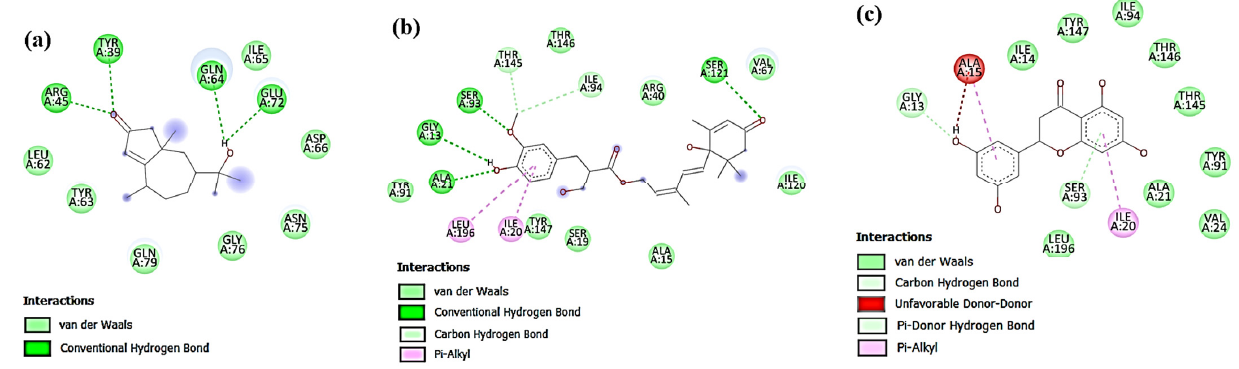
Figure 5. Two-dimensional (2D) molecular interactions of ( a ) Compound C3 ; ( b ) Compound C5 ; and ( c ) Compound C7 with enoyl-acyl carrier protein reductase of S. aureus (FabI) (PDB ID: 3GNS), (dimensions (Å); X:43.7680, Y: 51.7046, Z:49.0095), (root mean square deviation) RMSD < 2.